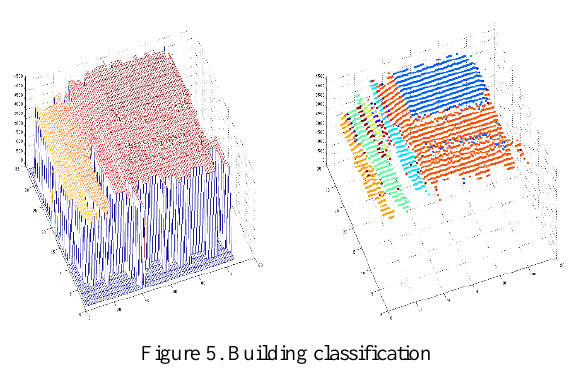
Figure 5. Building classification